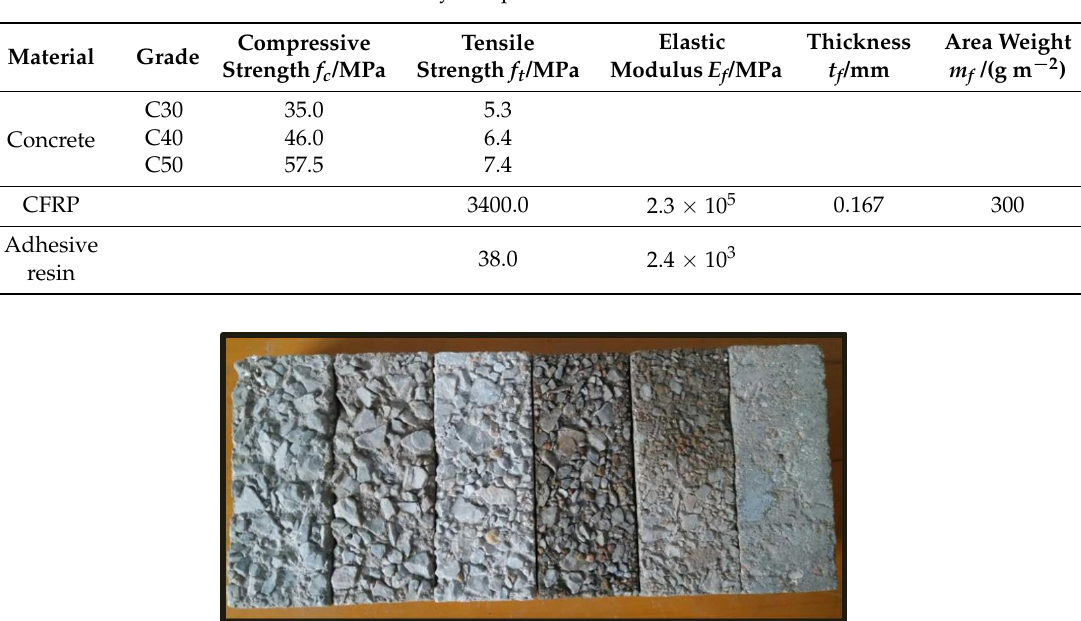
Table 2. Physical parameters for material.